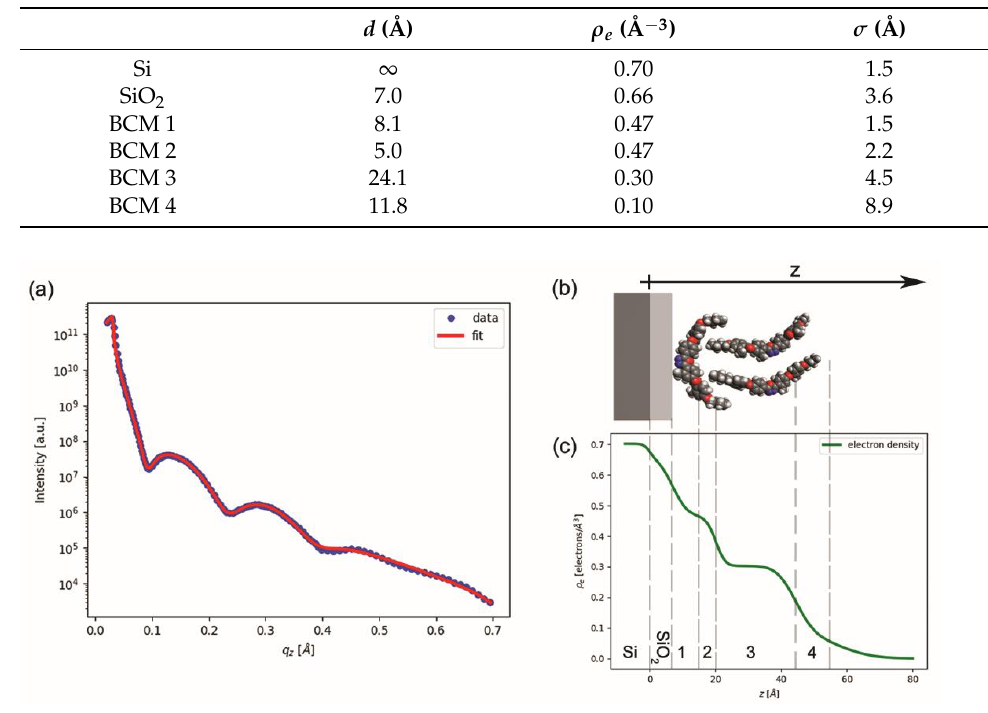
Figure 4. ( a ) XRR curve: experimental data (blue dots) and fitting curve (red line). ( b ) Structural model of the BCM film over the silicon and silicon oxide layers (grey and light grey, respectively). ( c ) Electron density ( ρ e ) vs. film thickness ( z ), as obtained from fitting the XRR curve with the multilayer model described in the text. Grey dashed lines show the resulting thickness of each layer (see Table